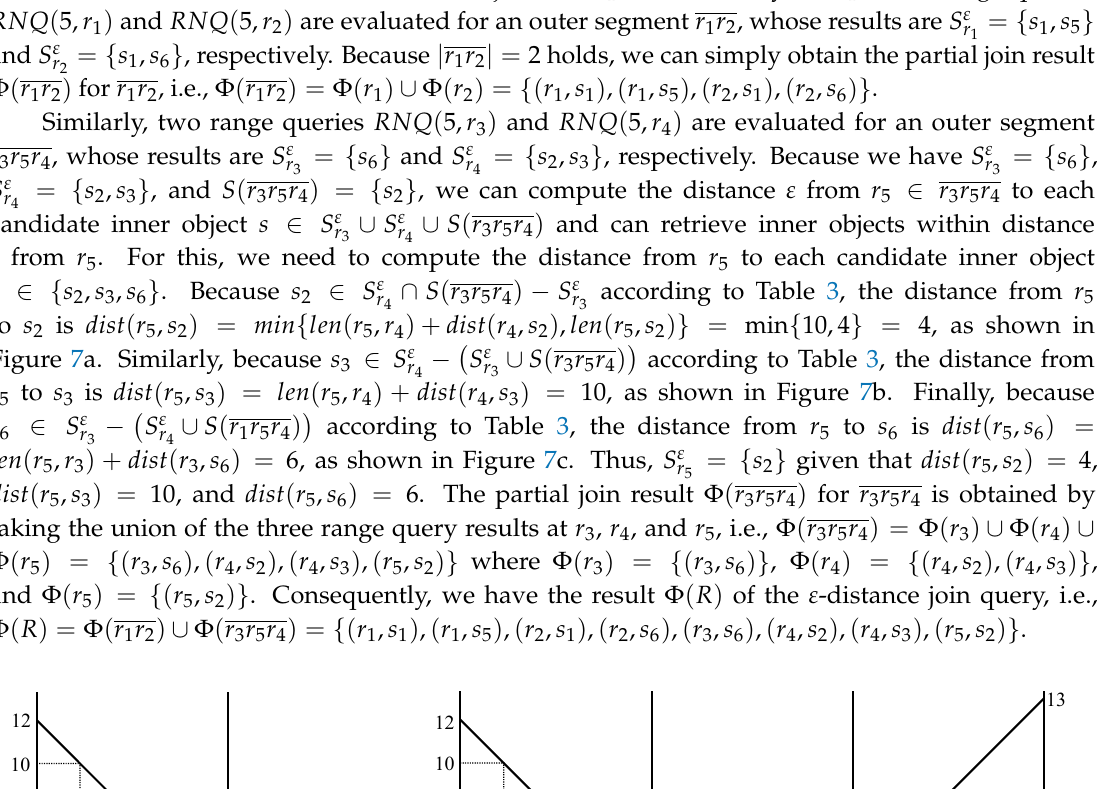
− (cid:0) S ε ∪ S ( r ) (cid:1) according to Table 3, the distance from 3 r 5 r 4 r 4 r 3